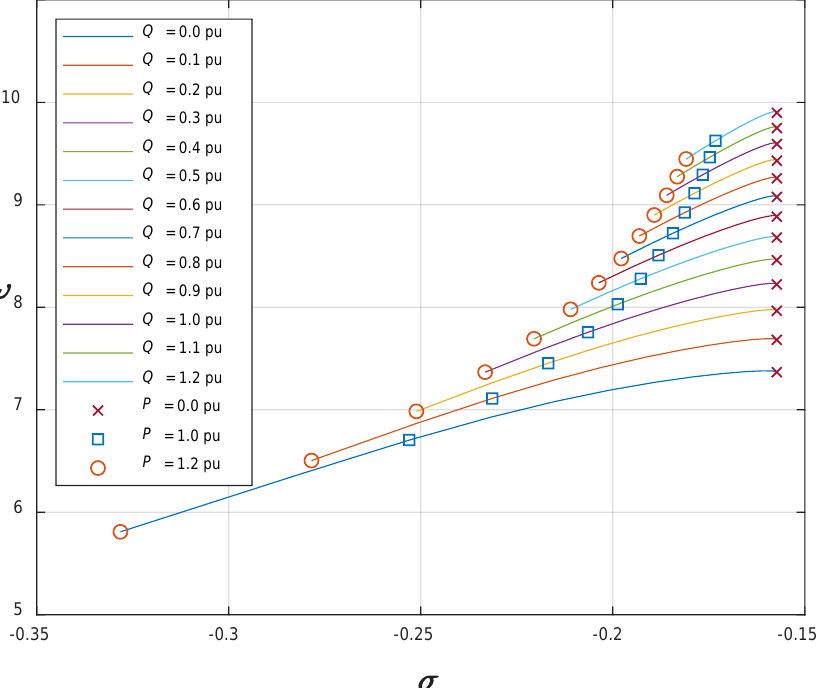
Figure 3. Eigenvalue loci of local mode of 158-MVA hydro-type synchronous generator without AVR.